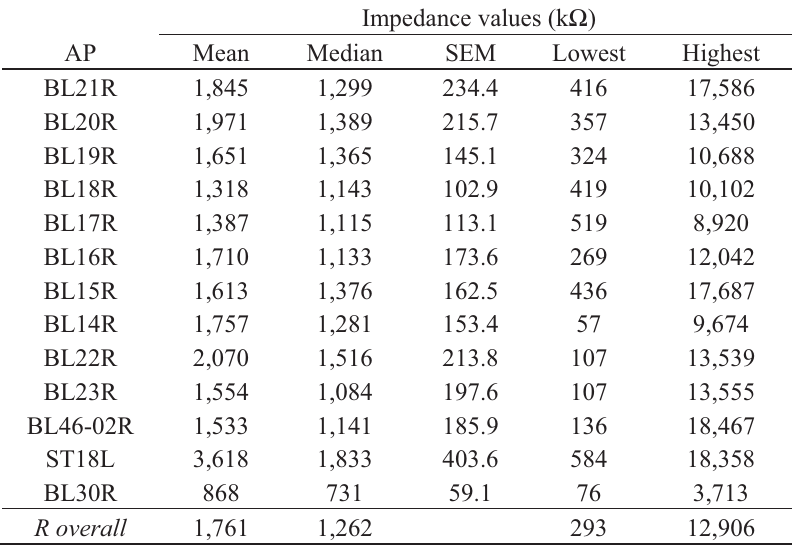
Table 2. Mean, median, standard error of the mean (SEM), highest and lowest impedance values in Experiment